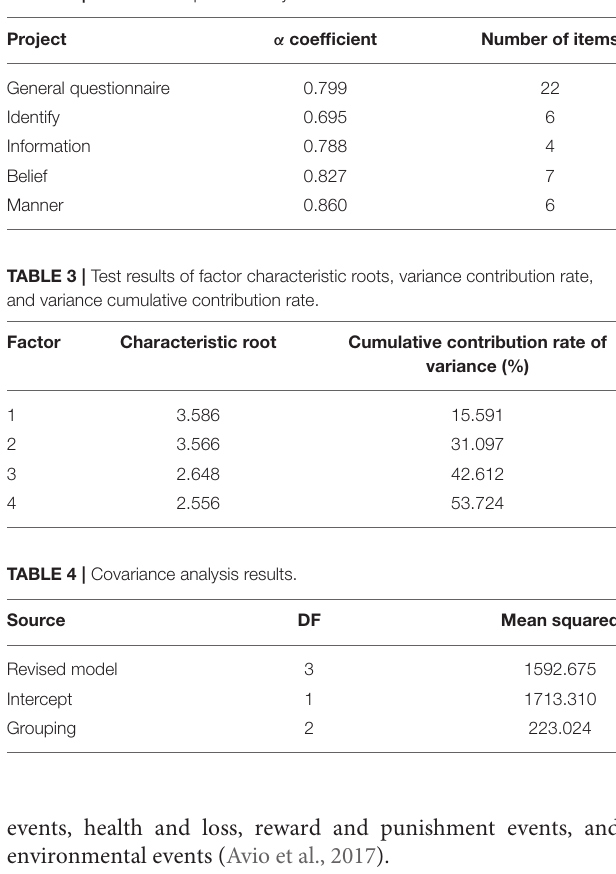
TABLE 2 | Cronbach’s alpha reliability evaluation.